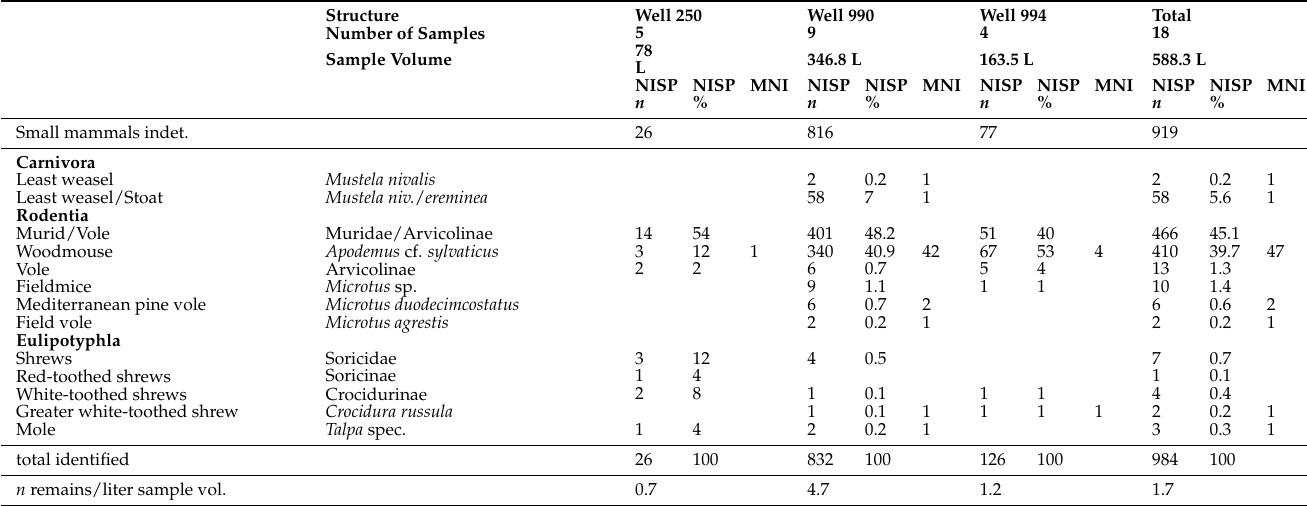
Table 2. Number of identified specimens (NISP) and minimal number of individuals (MNI) of small mammals from wells 250, 990, and